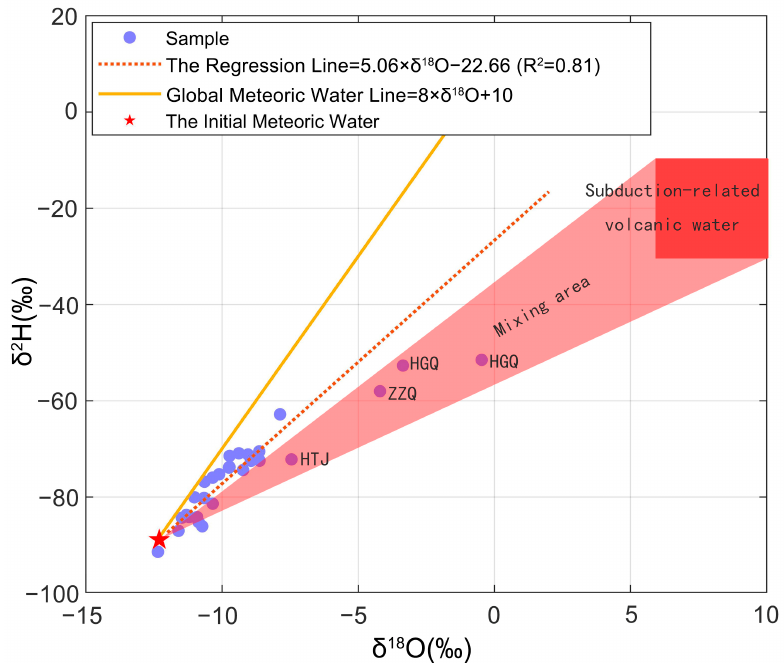
Figure 3. Stable hydrogen and oxygen isotopic compositions of hydrothermal fluids collected from Tengchong. The Global Meteoric Water line (GMWL, δ 2 H = 8 × δ 18 O + 1, [64]). Volcanic water resulting from subduction − related volcanic vapor has δ 2 H values ranging from − 10 to − 30‰ and δ 18 O values from +6 to +10‰ [59,60]. The Evaporation Water Line ( δ 2 H = 5.1 × δ 18 O − 26.7, R 2 = 0.81) was derived from the linear regression of the Tengchong samples, intercepting the GMWL at − 89.76‰ ( δ 2 H), − 12.47‰ ( δ 18 O), and it is comparable to previously suggested curves − [55,67]. The intersection points are represented by pentagrams in the figure and represent the initial water sources.